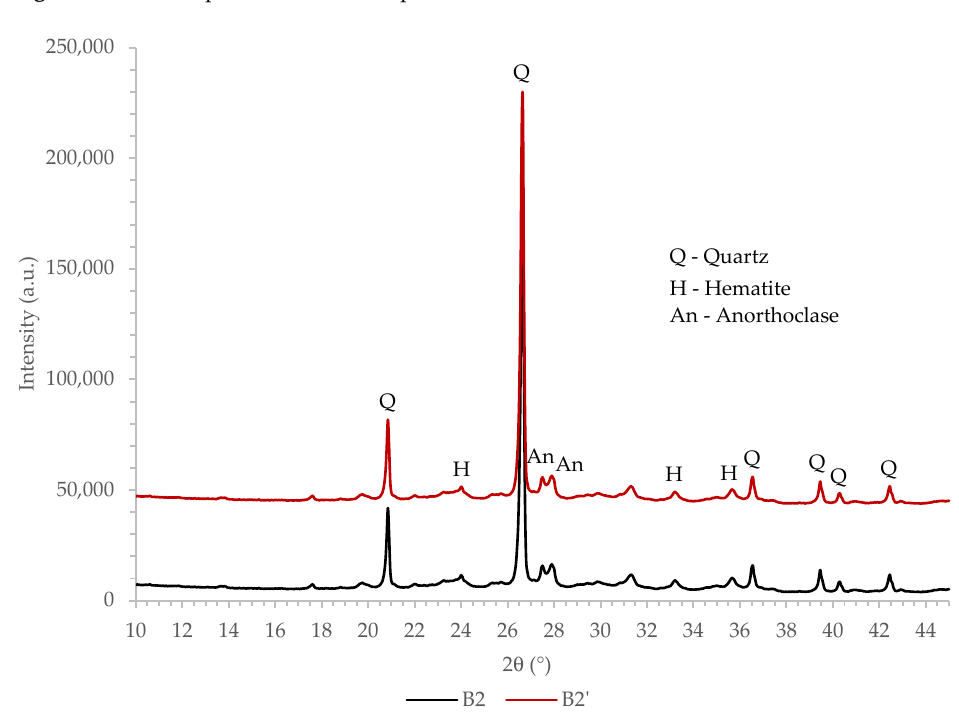
Figure 1. The XRD patterns of ceramic powder.